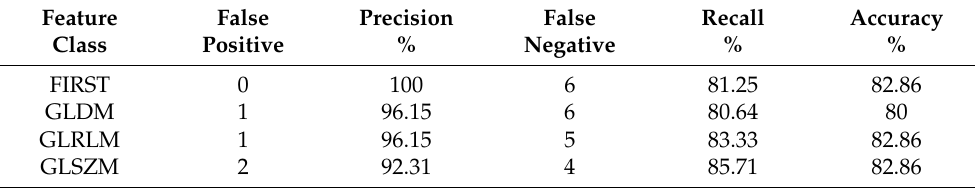
Table 4. Step 1: Results of the comparison between healthy and lung disease patients. Feature